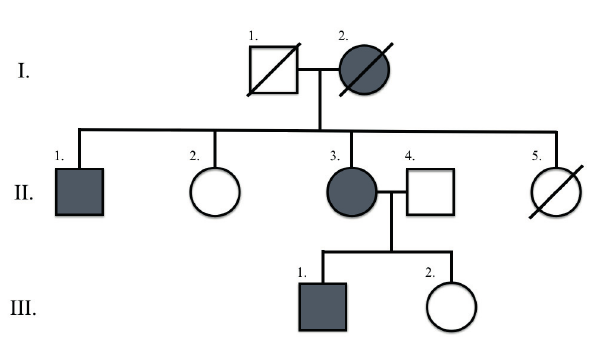
Fig. 1. Family pedigree. The family comprised of four affected members in three generations. Roman numerals (I-III) give the generation, arabic numerals (1-3) the individuals within one generation. Square - male, circle - female, filled symbol - af- fected subject, blank symbol - unaffected subject, diagonal